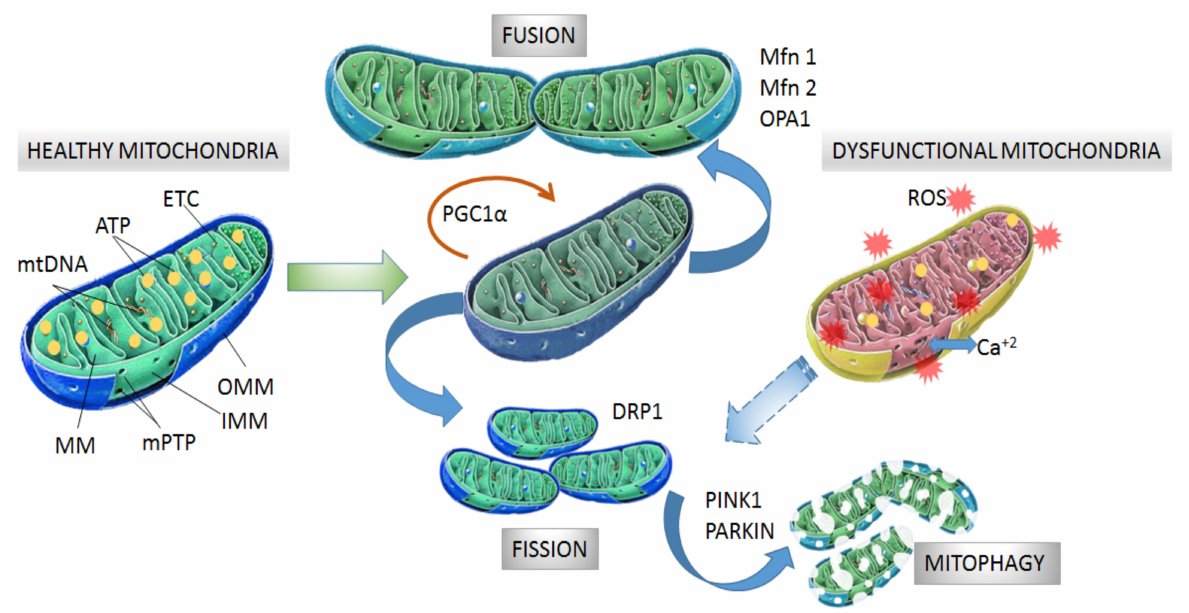
Figure 1. Structure and processes involved in dynamics of healthy and dysfunctional mitochondria. Healthy mitochondria display coordinated and dynamic processes of fusion and fission in order to regulate their morphology, size, and number. After mitochondrial biogenesis guided by PGC-1 α protein, fusion generates an interconnected mitochondrial network, which is orchestrated by OPA1, Mfn1 and Mfn2 proteins. Fission results in small size mitochondria without mtDNA replication due to fragmentation and separation from the mitochondrial network, which is a process driven by dynamin- related protein (DRP1). Fragmented mitochondria are degraded by mitophagy, which is a process involving PINK1 and PARKIN proteins. Dysfunctional mitochondria showing alterations in structure and function in neurodegeneration are degraded by mitophagy. Mitochondrial dynamics are maintained by constant activity and precise balance between the biogenesis and clearance of fragmented and defective organelles. mtDNA: mitochondrial DNA, ATP: adenosine triphosphate, ETC: electron transport chain, MM: mitochondrial matrix, mPTP: permeability transition pore, OMM: outer mitochondrial membrane, IMM: inner mitochondrial membrane, PGC-1 α : peroxisome proliferator activated receptor-gamma coactivator 1-alpha, Mfn1 and